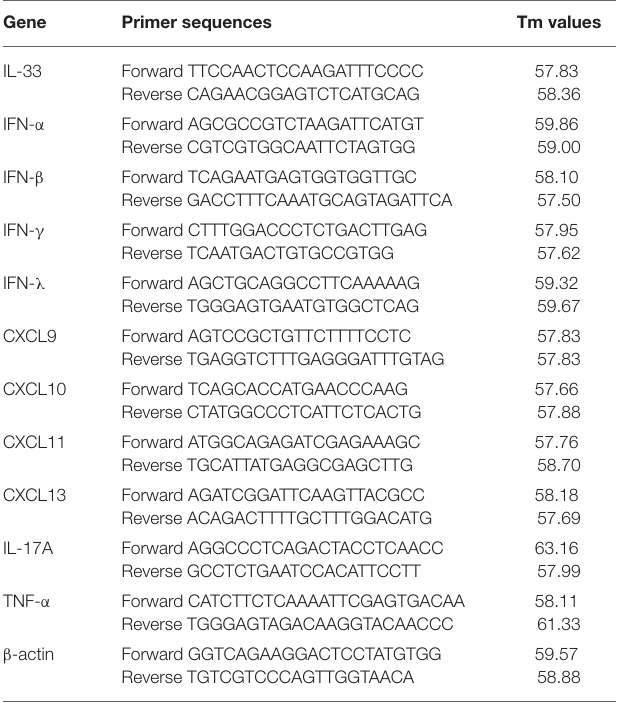
TABLE 1 | The primer sequences of the genes.